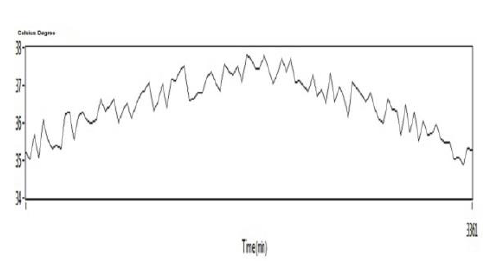
Figure 18. Humidity data logged by wireless sensor network monitoring system and HIH400 analog sensor.